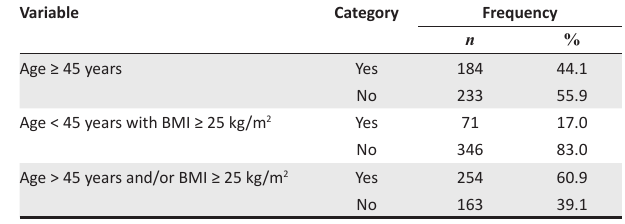
TABLE 5: Magnitude of missed opportunity based on the guideline-recommended major criteria for prediabetes screening.